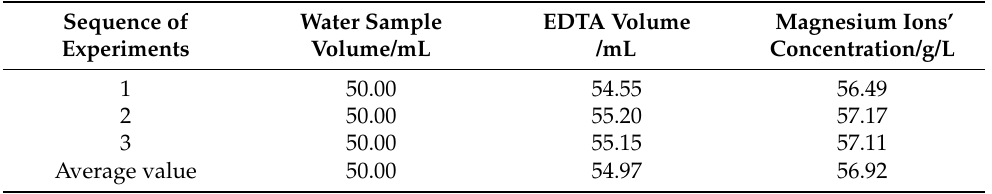
Table A1. The results of magnesium ions concentration in a